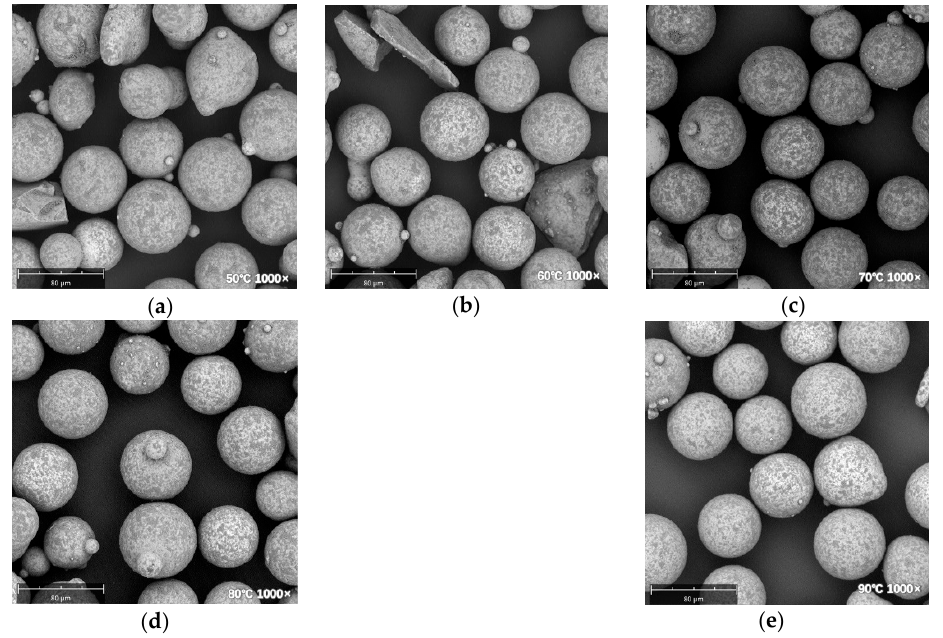
Figure A2. SEM images from experiments under different fluidization temperatures ( a ) 50 °C; ( b ) 60 °C; ( c ) 70 °C; ( d ) 80 °C; ( e ) 90 °C.